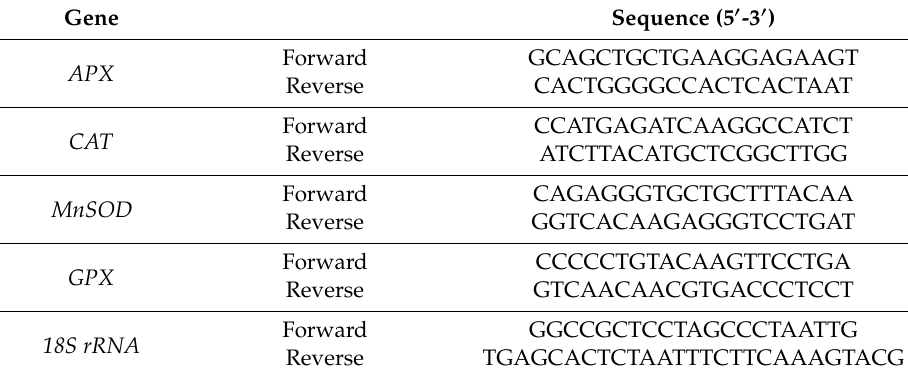
Table 1. Sequence of specific primers used in this study